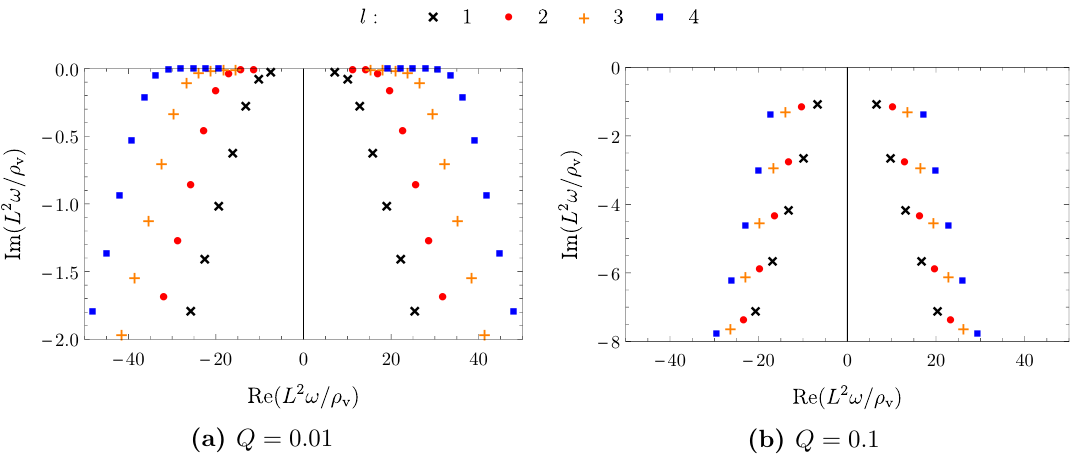
Figure 6. The complex frequency plane ! , in units of (cid:26) v =L 2 , showing QNM frequencies of the (cid:13)uctuations B l for (a) Q = 0 : 01 or (b) Q = 0 : 1 and l = 1 ; 2 ; 3 ; 4 (black crosses, red dots, orange plus signs, blue squares,